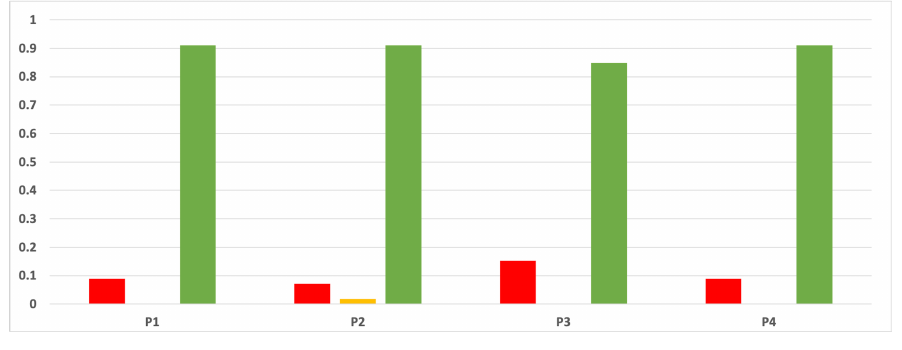
Figure A12. Experiment 1: consistency per partition (MCC and time complexity). ( a ) Rate of validity per partition in DT. ( b ) Rate of validity per partition in KNN.